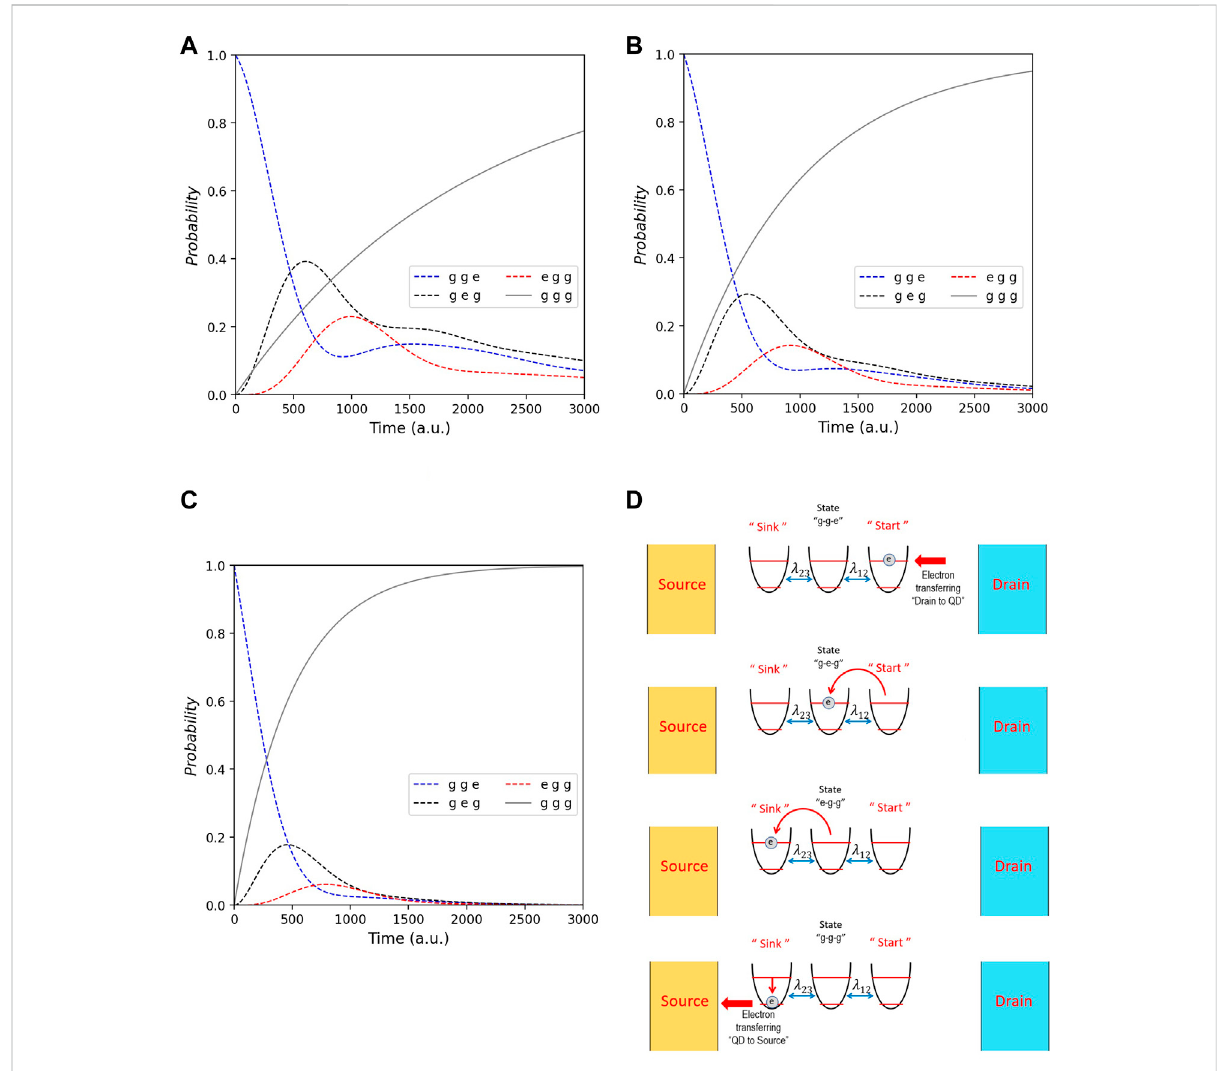
FIGURE 3 Probability of all states that are gge (blue line), geg (black line), egg (red line), and ggg (gray line) for λ 1,2 = 2 (a.u.). Each picture demonstrates the wholetendencyofprobabilitywithdifferent Γ 0 thatare0.25 for (A) ,0.5for (B), and1for (C) . (D) Schematicmechanismofenergytransportbeginning from the drain gate to the source